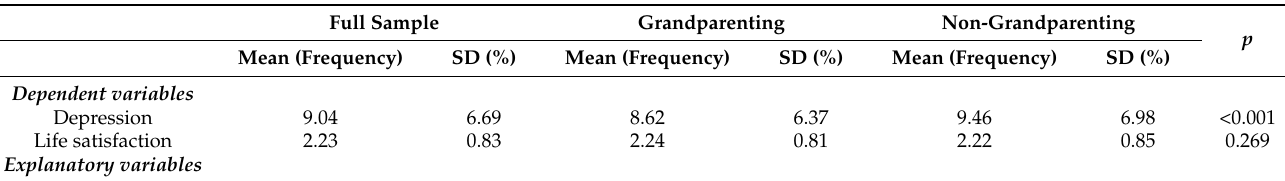
Table 1. Characteristics of the variables, by grandparenting